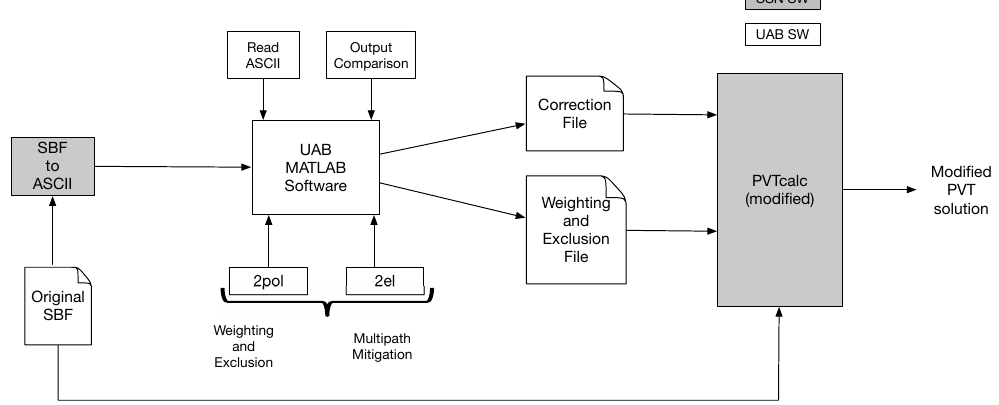
Figure 12. Sketch of the procedure carried out to obtain the results presented in Section